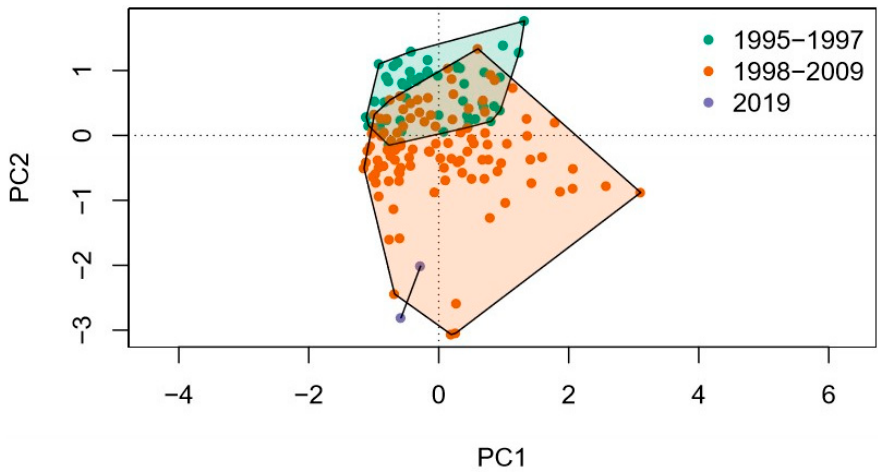
Figure 3. Plot of principal component analyses of deployed reed and natural reed samples from points a4 and a6 in the Ásvány branch system. Different colors denote sampling periods.